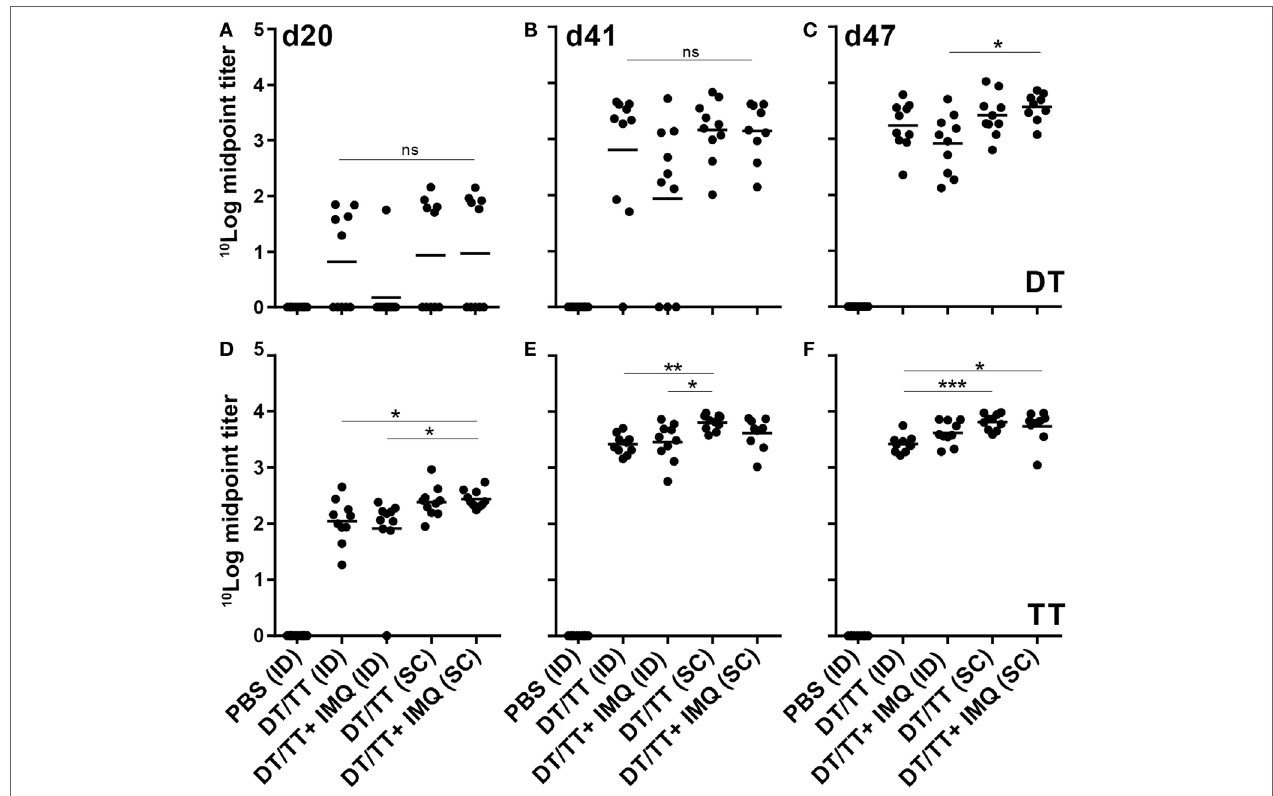
FigUre 5 | Serum immune globulin G (IgG) responses (mean + individual results) after immunization with phosphate-buffered saline or diphtheria toxoid (DT) and tetanus toxoid (TT) intradermal (ID) loaded onto nanoporous microneedle array or SC, both routes with or without imiquimod (IMQ). When IMQ was added, only half of the antigen dose was applied. IgG responses were detected against DT antigens (a–c) and TT antigens (D–F) . Kruskal–Wallis test with Dunn’s post hoc test was performed to determine statistical differences between midpoint titers determined using four different titers